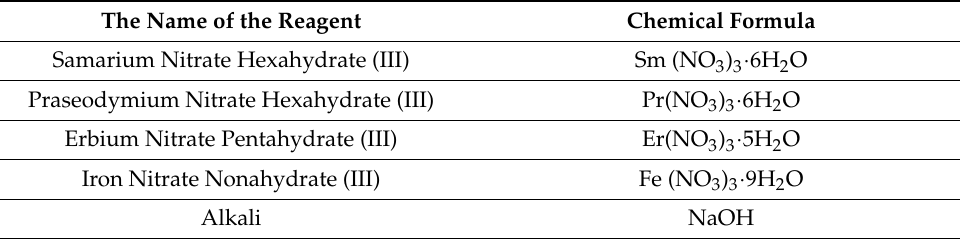
Table 1. Chemical reagents used in the synthesis of the